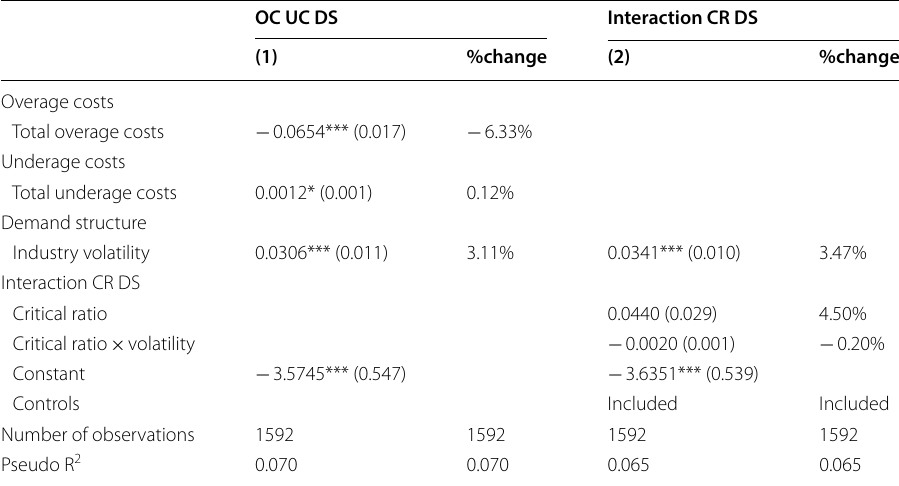
Table 6 Main determinants of the training intensity for firms with collective